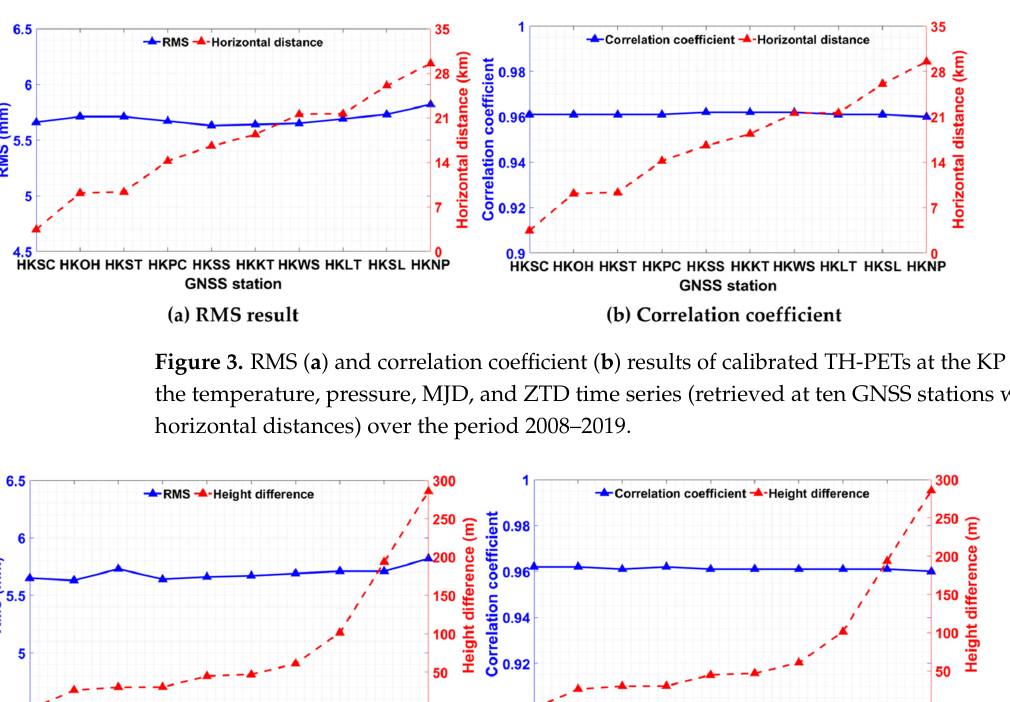
all retrieved. According to Section 4.1, ZTD estimates have already been proven effective to calibrate TH-PET values; however, all of the previous experiments only used the GNSS and meteorological products obtained at the three pairs of co-located GNSS/weather stations to ensure their rationality. Therefore, determining whether the spatial distribution of GNSS and weather stations may have a remarkable effect on the calibration results of TH-PETs affects the feasibility and extension of this application in future practices. In this section, with the use of temperature and pressure measurements collected at the three weather stations (HKA, KP, and ST), as well as the time-varying variable of MJD, the retrieved ZTD values at each of the ten GNSS stations were used to calibrate the TH-PETs at the Table 6. Calibration performances of TH-PETs resulting from the temperature, pressure, MJD, and weather stations. Because the horizontal distances and height differences between each ten sets of ZTD time series at the three weather stations (HKA, KP, and ST) over the period 2008– pair of GNSS and weather stations are different, the factor of spatial distribution is divided 2019. The height differences between each pair of GNSS/weather stations are illustrated. into two parts to separately investigate the influences brought by the differences in the HKA Station KP Station ST Station horizontal and vertical directions. Therefore, by using the PM-PET values calculated at each weather station as the reference, Tables 5 and 6 list the calibration performances of RMS TH-PET time series at the three weather stations resulting from the variables of temperature, pressure, MJD, and ZTD (retrieved at each of the ten GNSS tracking stations) over the 12-year period from 2008 to 2019. The reasons for using data over this period are the same as those stated in Section 4.2. It is also noted that only the metrics of RMS and correlation coefficient were adopted in this comparison, which can better illustrate the accuracy and correlativity, respectively. The horizontal distances and height differences between each pair of GNSS and weather stations illustrated in Tables 5 and 6 were all calculated based on their coordinate information listed in Table 1. These results at each of the three stations all possess qualitatively similar variation trends, as shown in these tables. To make a clearer visual comparison, the KP station is selected as a typical case, and the results obtained are plotted in Figures 3 and 4 to test the performances affected by different horizontal and height differences, respectively.